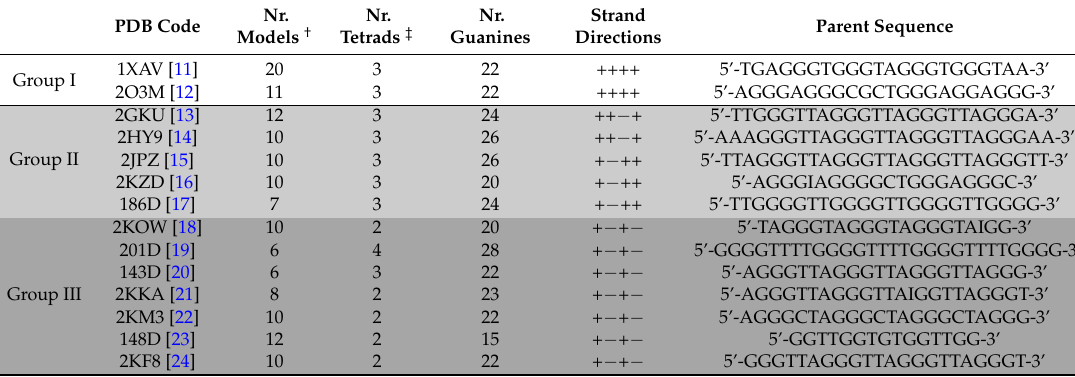
Table 2. Summary of the computed